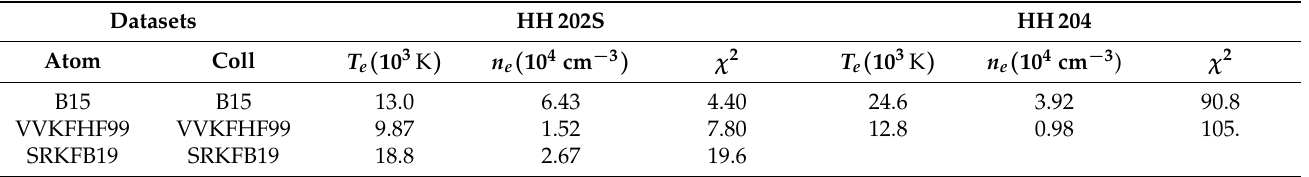
Table 10. Temperature and density fits of the [Fe II ] observed spectra of HH202S and HH204 with the radiative ( atom ) and collisional ( coll ) datasets currently available in PyNeb